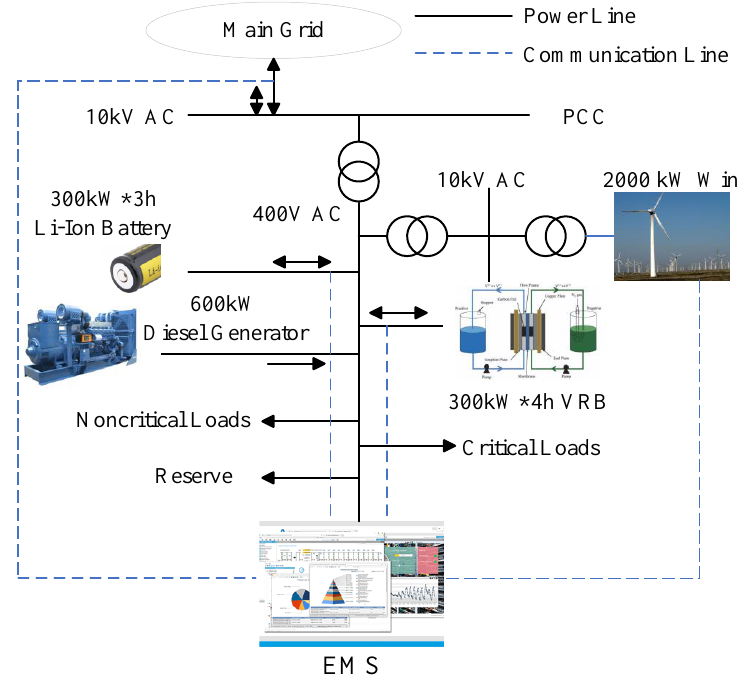
Figure 1. Framework of the case study microgrid. EMS: energy management system.